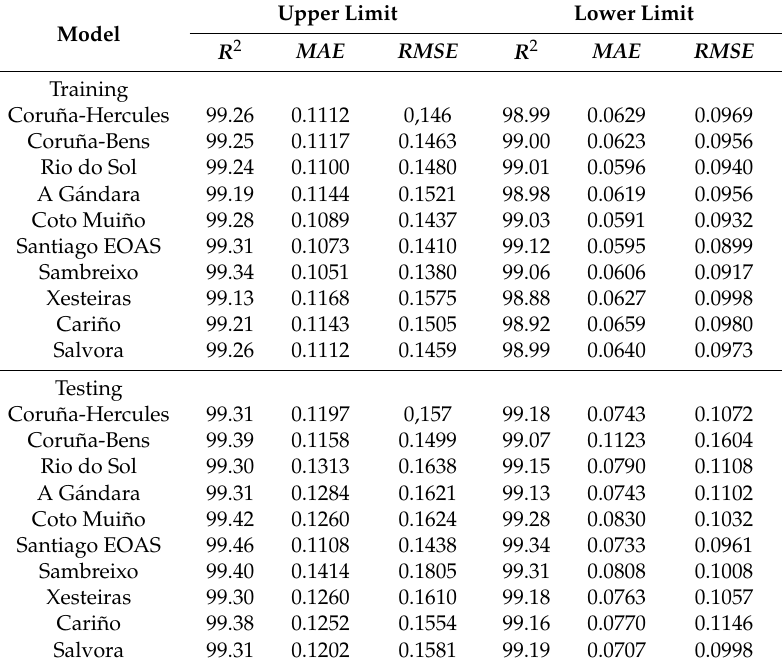
Table 8. Results of the training and testing of the MLP models of approach 1.